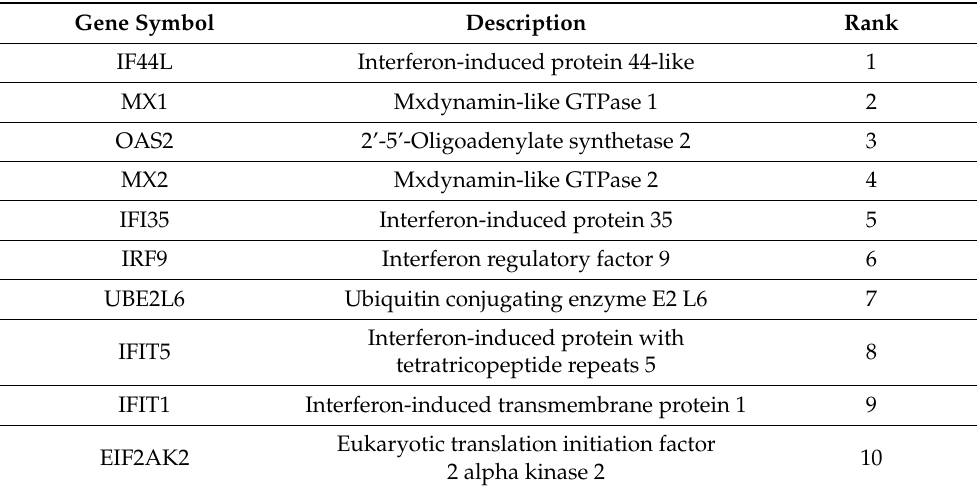
Table 1. Top ranked genes extracted from the network constructed from rheumatoid arthritis and periodontitis.